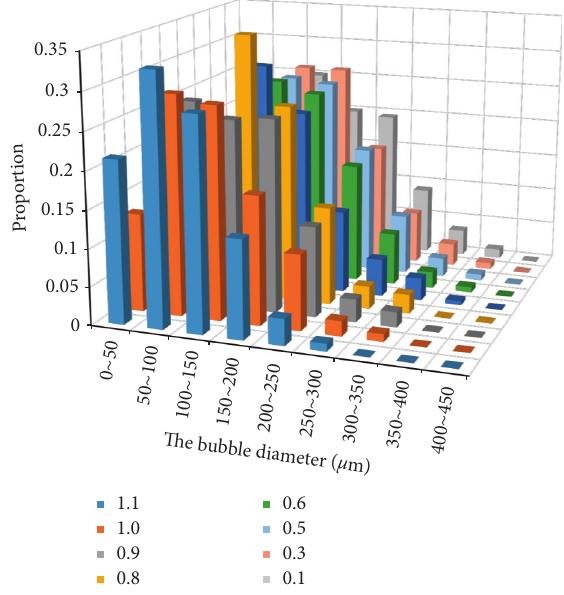
Figure 11: Particle size distribution of foam under different xanthan gum